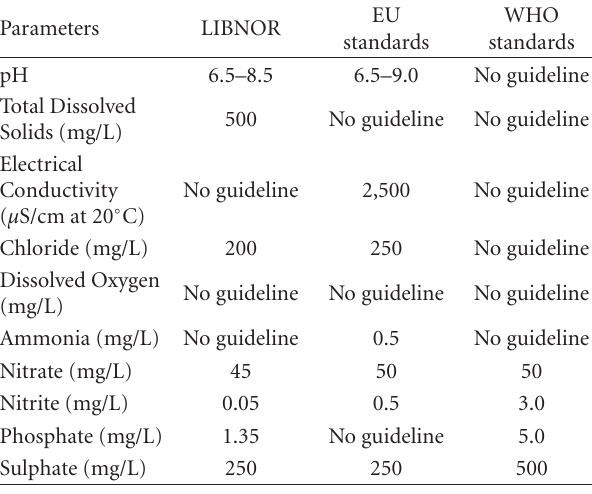
Table 1: Comparison of various drinking water